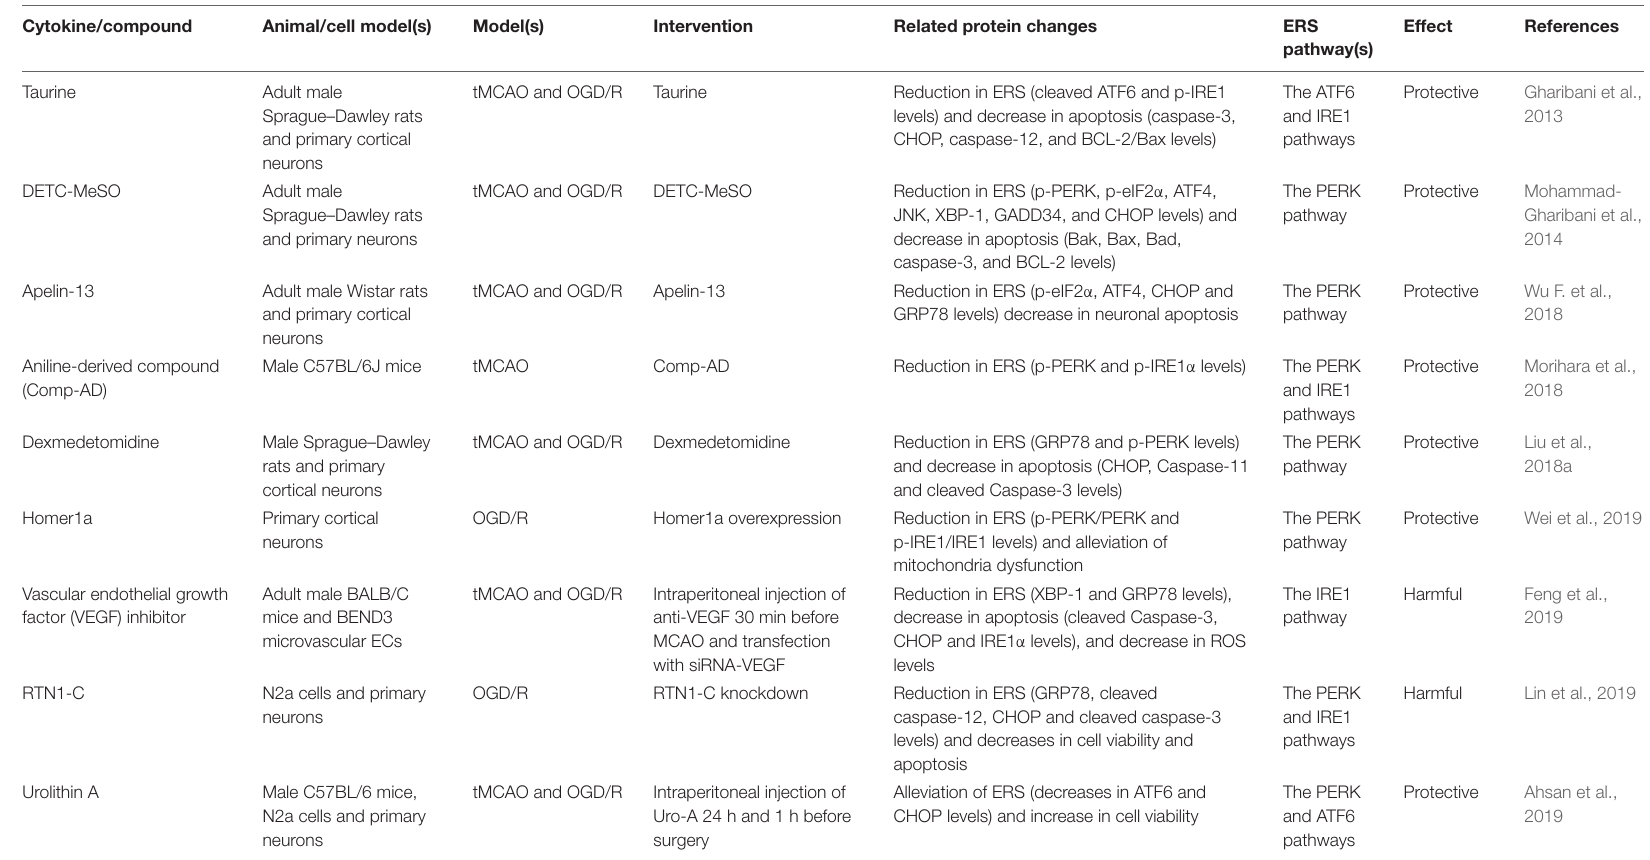
TABLE 1 | Several cytokines/compounds exacerbate or mitigate cerebral ischemia/reperfusion injury (CIRI) by regulating endoplasmic reticulum stress (ERS).